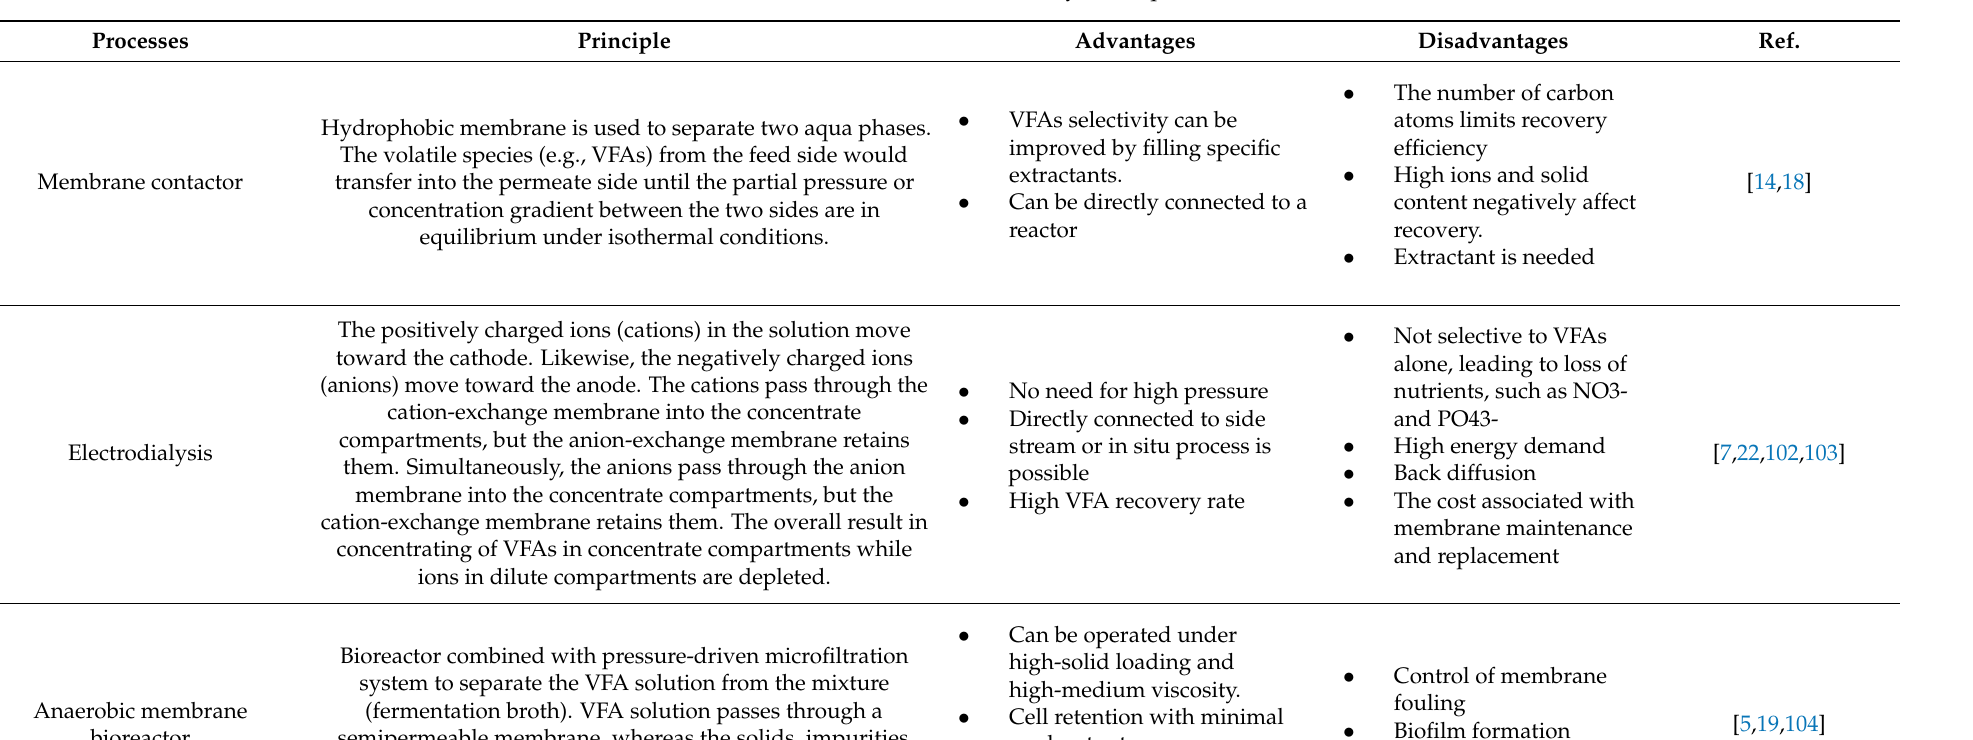
Table 3. Membrane-based VFA recovery